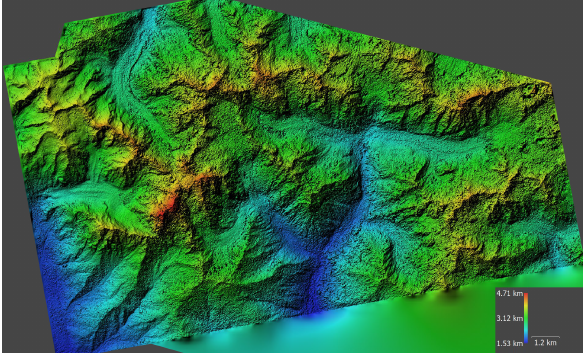
Figure 4. Colour-coded DSM calculated from 11 PlanetScope scenes from Jaspersen